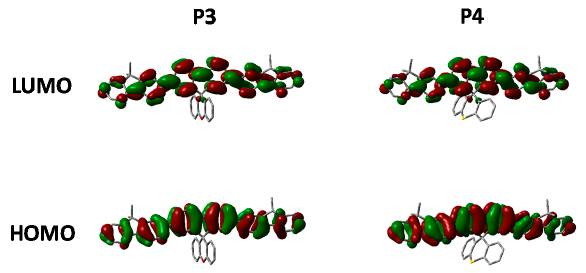
Figure 7. HOMO and LUMO orbitals of P3 and P4 (DFT B3LYP/6-31G* isovalue 0.02).